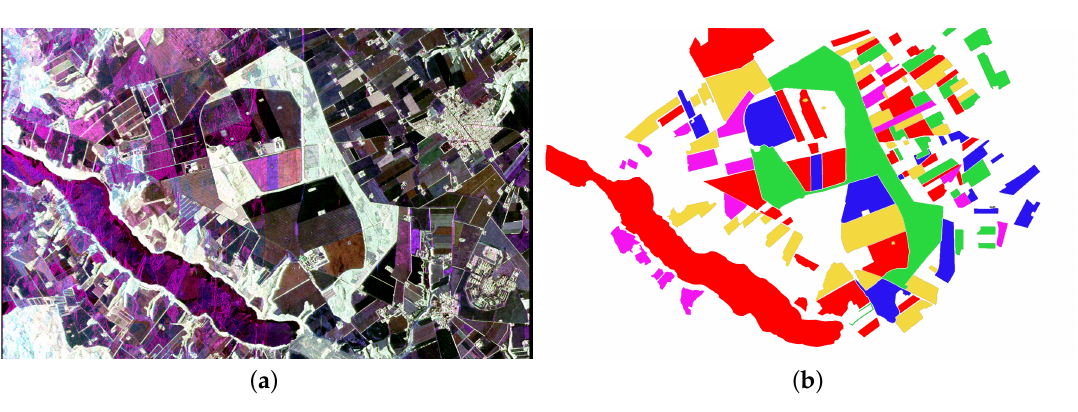
Figure 8. ( a ) The color image of Foulum data set which is used to get sampled data sets. ( b ) The corresponding segmentation ground truth.